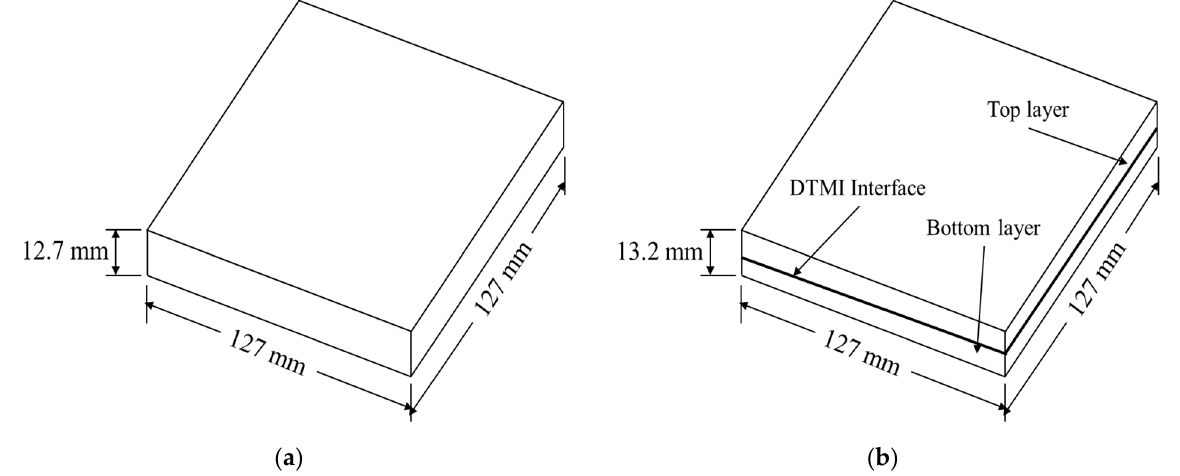
Figure 2. Schematic diagram of ( a ) a baseline specimen and ( b ) a layered specimen.